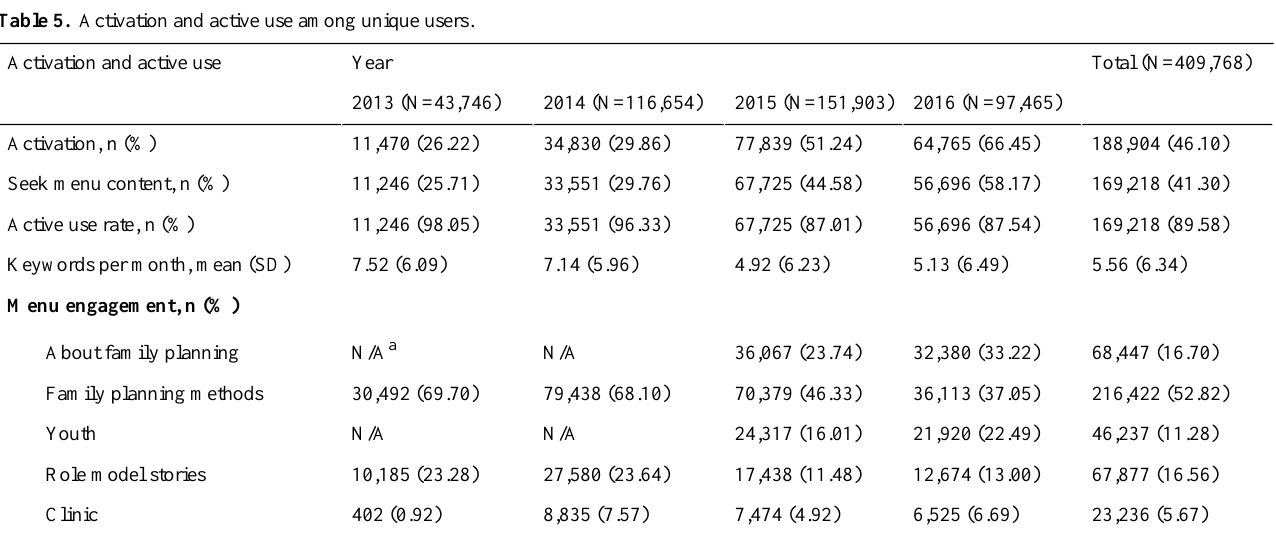
Table 5. Activation and active use among unique users.